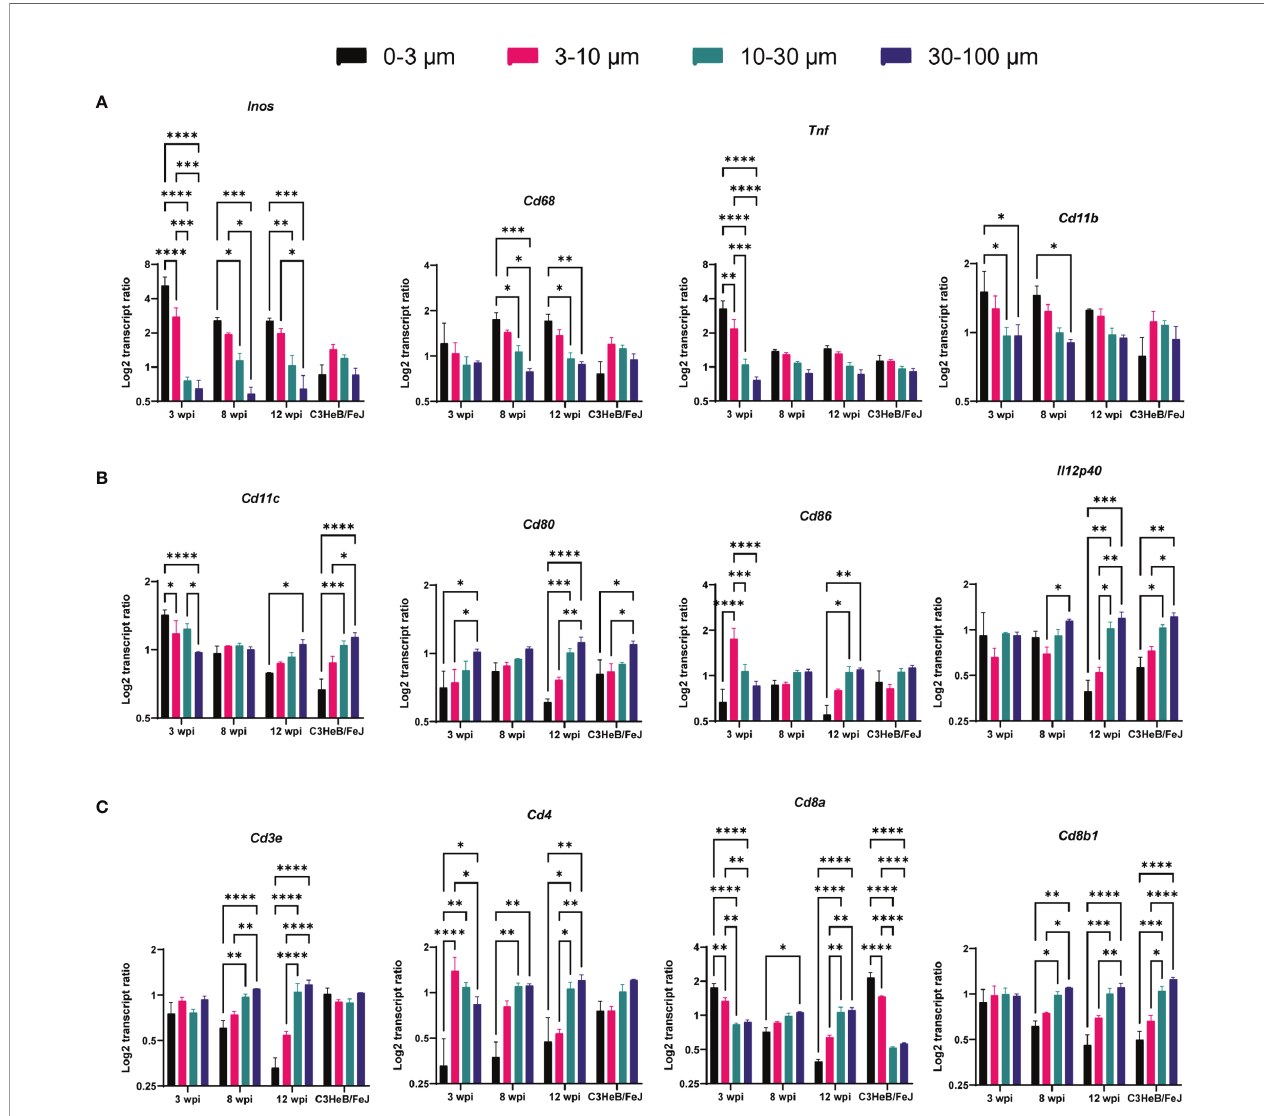
FIGURE 3 | Single bacteria identi fi cation and their immune environment per transcript. Transcript frequency ratios for indicated distances to bacteria were identi fi ed in C57BL/6 mice 3, 8, and 12 wpi and in C3HeB/FeJ mice at 10 wpi. Transcript frequencies for (A) Inos, Cd68 , Tnf , and Cd11b; (B) Cd11c , Cd80 , Cd86 , and Il12p40 ; and (C) Cd3e , Cd4 , Cd8a , and Cd8b1 are displayed. The transcript frequency ratios were calculated as the % of a transcript at a selected distance divided to the % of this transcript in the total slide. The mean of log2 ratio ± SEM of indicated transcripts in three sections per condition are shown (ANOVA, * for p < 0.05, ** for p < 0.01, *** for p < 0.001, and **** for p <